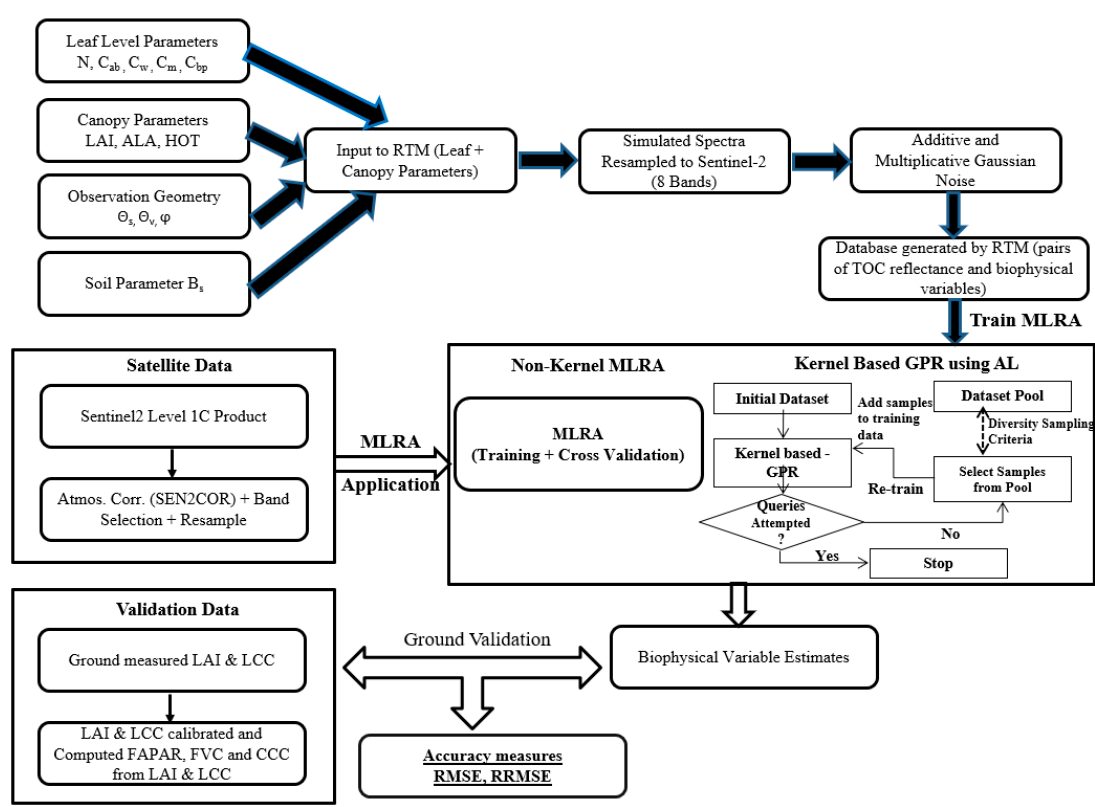
Figure 1. Flow-chart of the methodology used for the present study. Retrieval of biophysical variables: Leaf area index (LAI), Leaf chlorophyll content (LCC), Fraction of vegetation cover (FVC), Fraction of absorbed photosynthetically active radiation (FAPAR) and Canopy chlorophyll content (CCC). Radiative Transfer Model (RTM) parameters abbreviations are reported in Table 1. The RTM was used to train Machine Learning Algorithms (MLRA) including Gaussian Process Regression (GPR) using Active Learning (AL). Accuracy was assessed using the root mean squared error (RMSE) and relative RMSE (RRMSE).